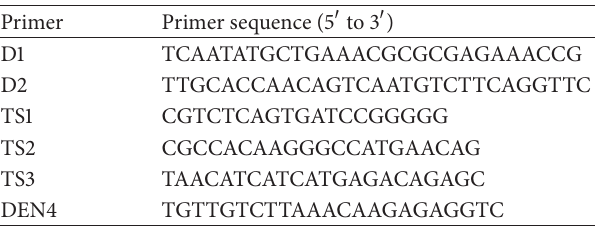
Table 1: The oligonucleotide primers used in RT-PCR (first and second